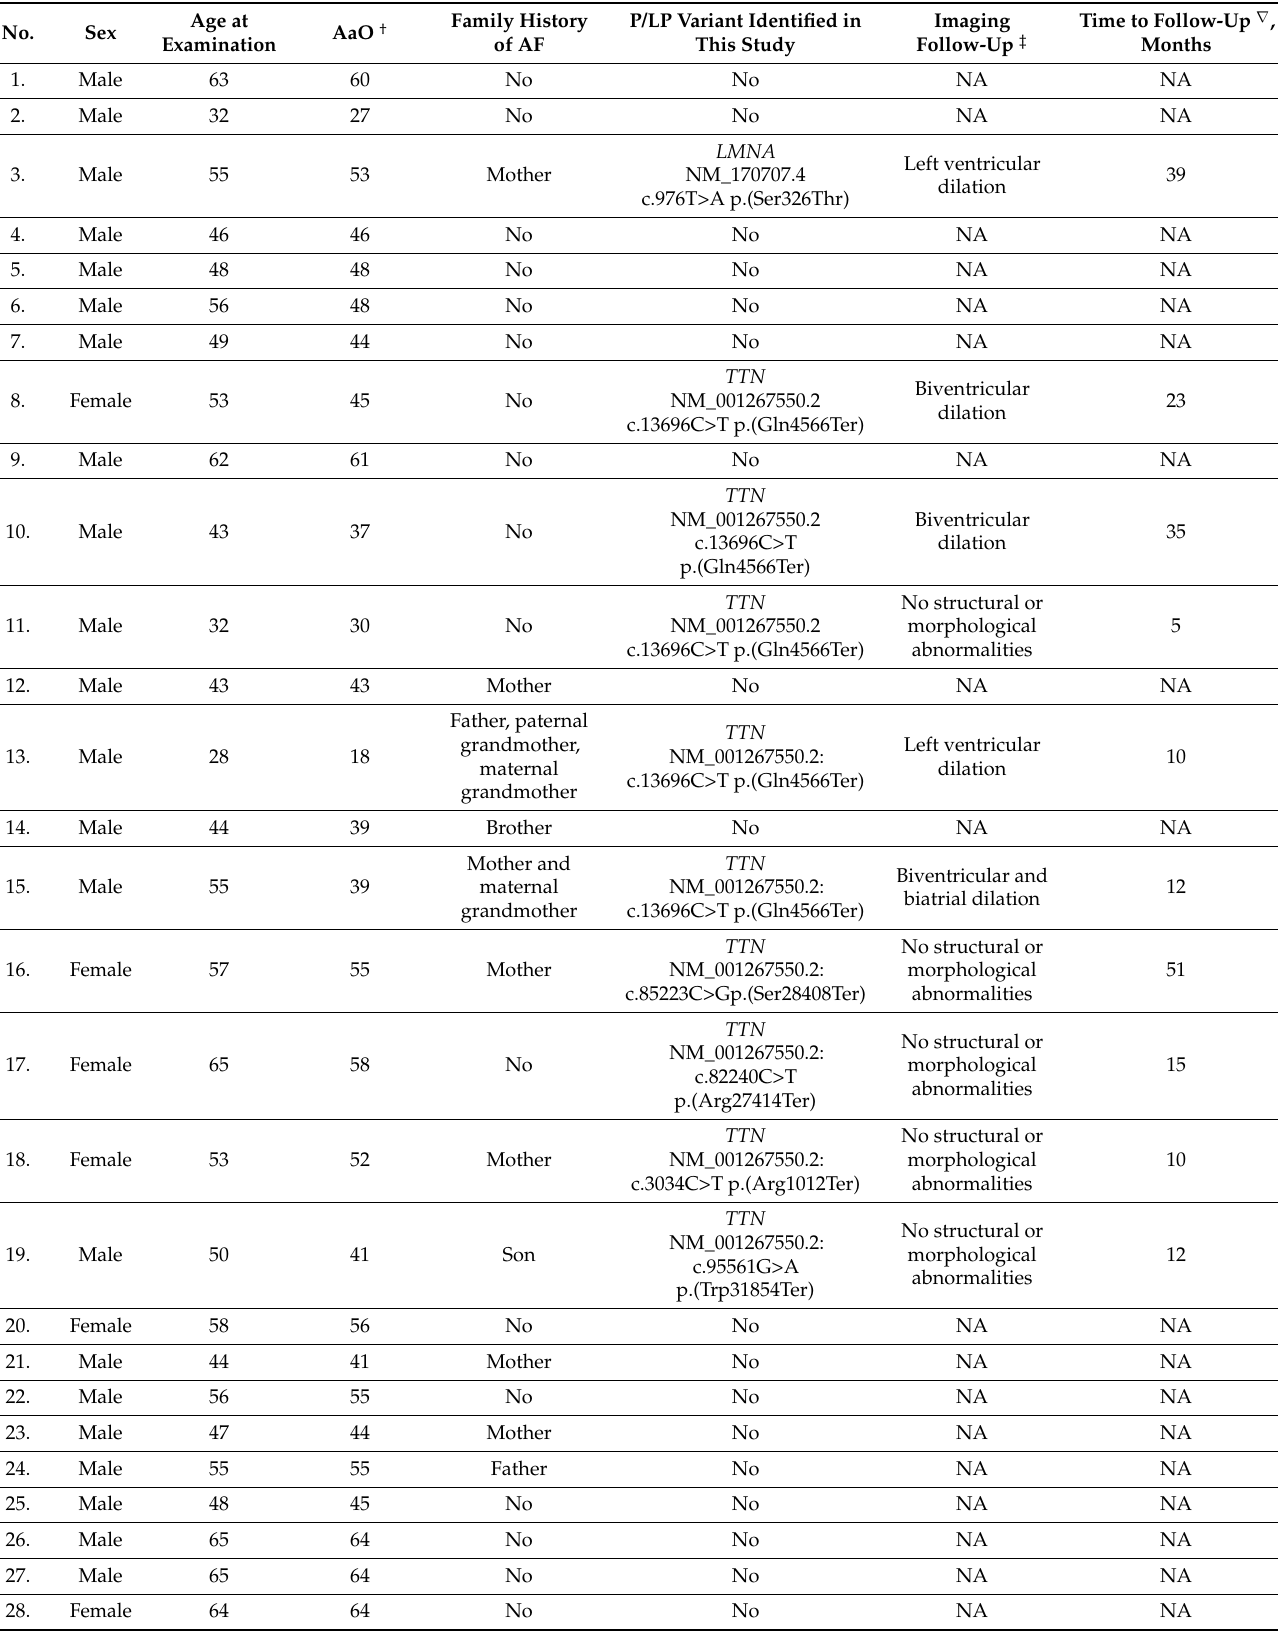
Table 1. Description of the atrial fibrillation patients and their genetic testing